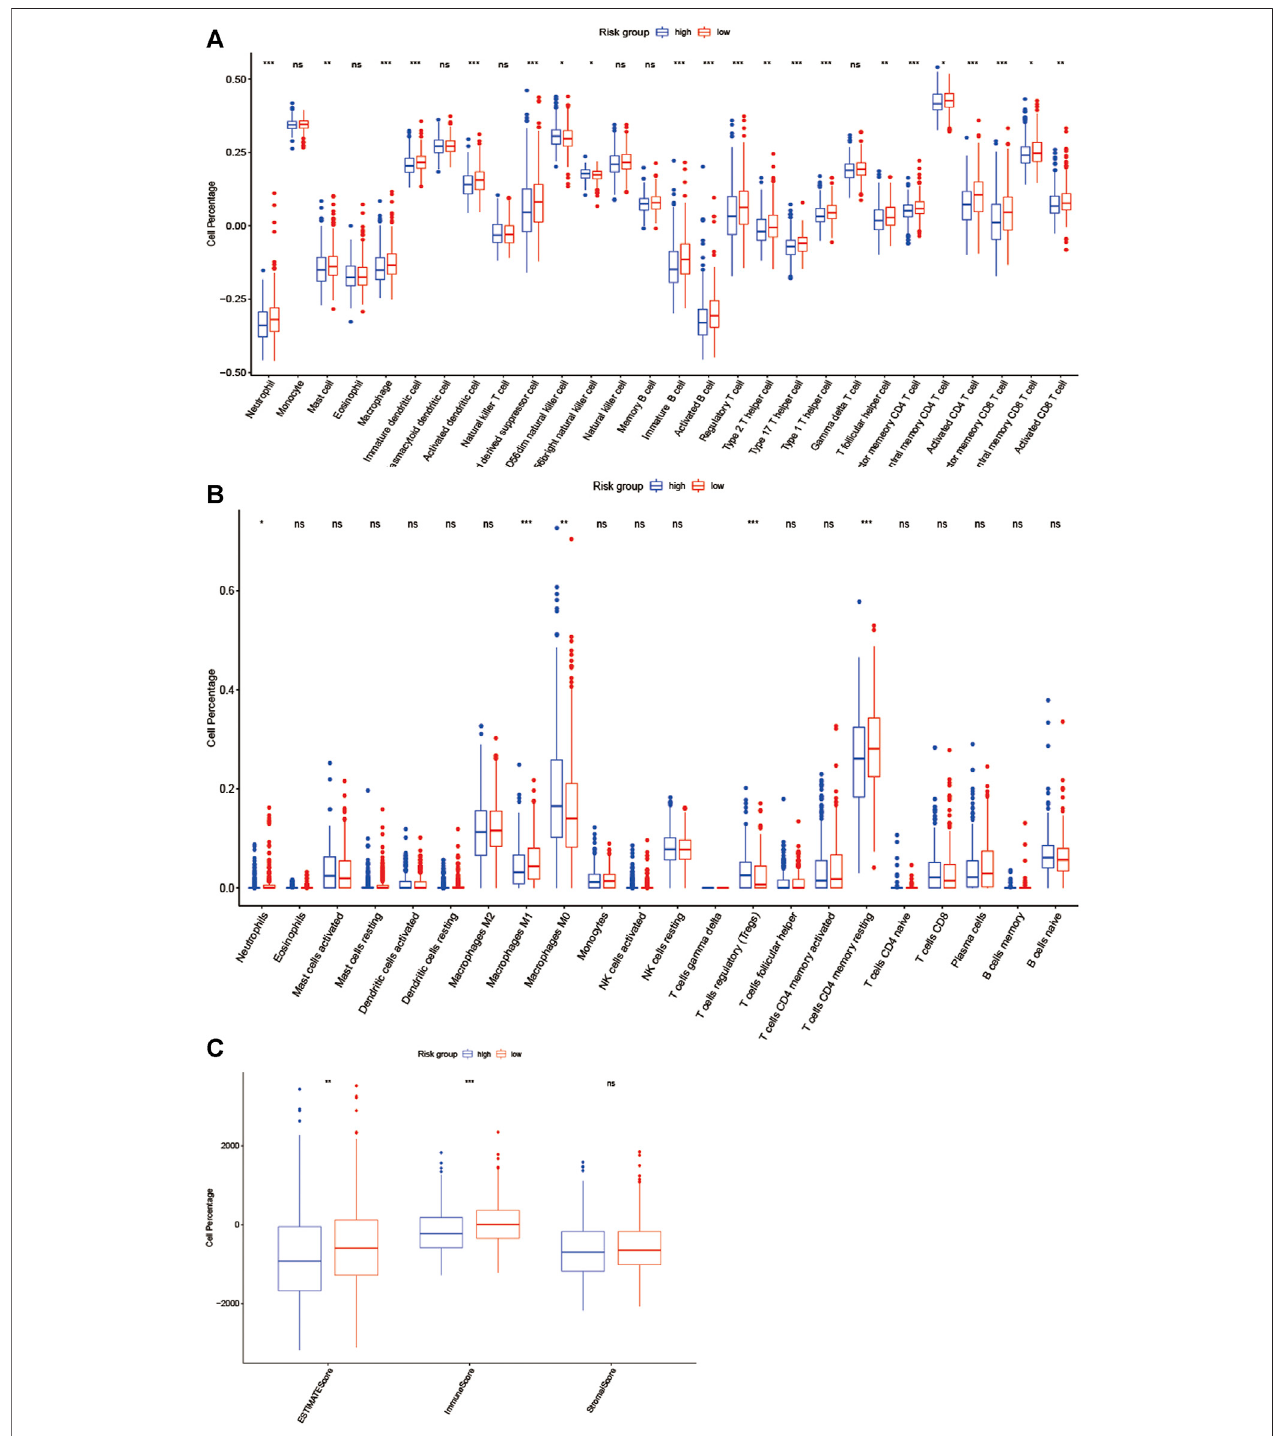
FIGURE 7 | EMT-related lncRNA clusters signi fi cantly associated with the immune microenvironment. (A, B) Statistical differences in each type of immune cell between high-risk group and low-risk group using ssGSEA approach (A) and CIBERSORT algorithm (B) . (C) Stromal score and immune score were calculated via ESTIMATE method between high-risk group and low-risk group. (ns: not signi fi cant, * p < 0.05, ** p < 0.01, *** p < 0.001).